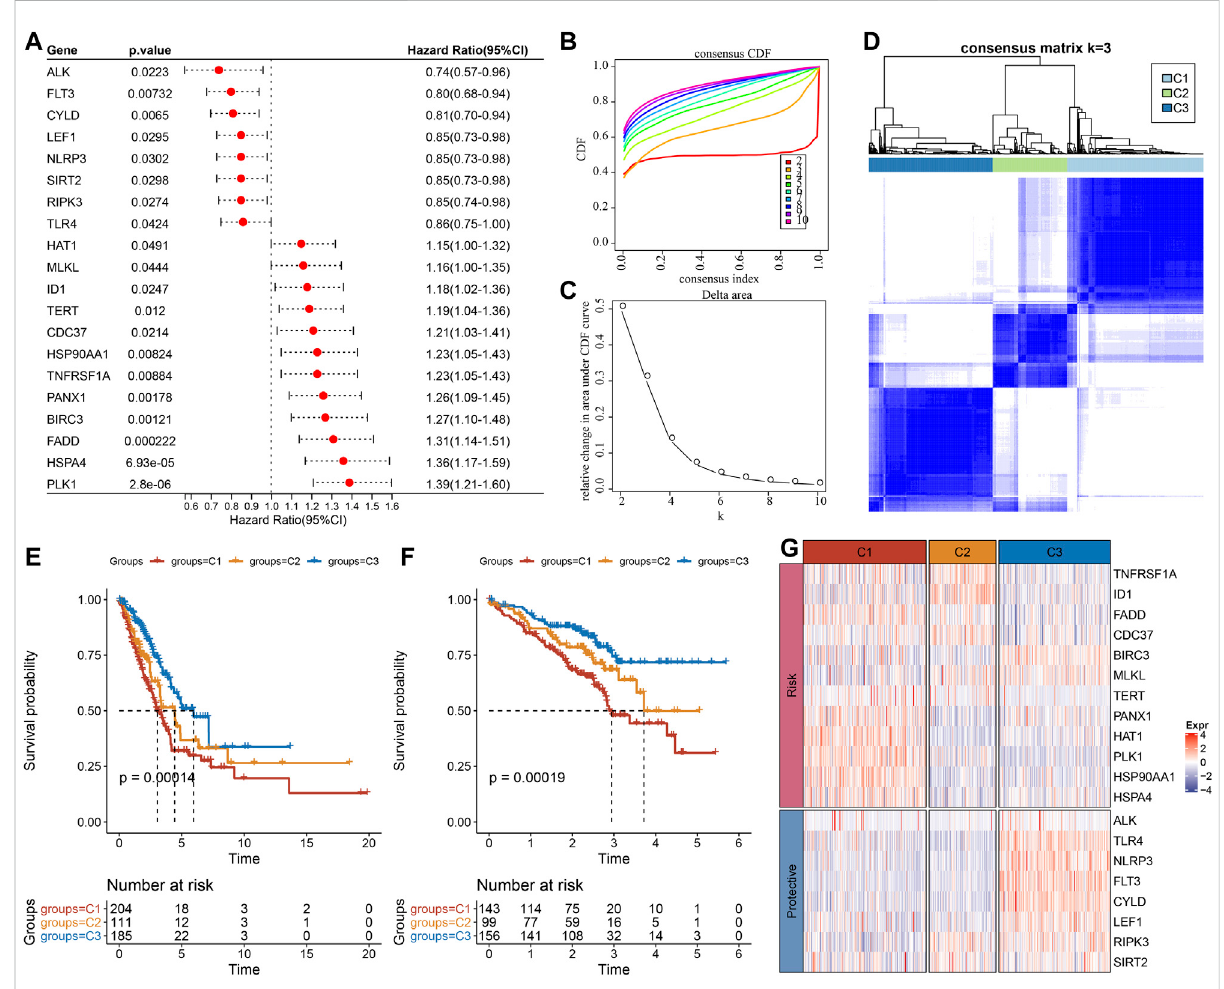
FIGURE 1 Moleculartypingresultsaccordingtothenecroptosis-relatedgenes. (A) Forestmapofgenesrelatedtonecroptosiswithsigni fi cantprognosisin TCGA cohort; (B) cumulative distribution function (CDF) curveof thesamples inTCGA cohort; (C) The CDF Delta area curveof TCGAcohortsample highlights the relative change of the area under the CDF curve of each category number (k) in comparison with K-1. The horizontal axis is for k, and theverticalaxisisfortherelativechangeoftheareaundertheCDFcurve; (D) SampleclusteringHeatmapwhenconsensusk=3inTCGAqueue; (E) Kaplan-Meier (KM) curve of overall survival (OS) prognosis of three subtypes in TCGA cohort; (F) Prognostic variations in the three molecular subtypes intheGSE72094 cohort; (G) The heat mapof theexpression of necroptosis genes withsigni fi cant prognosis indifferentsubtypes